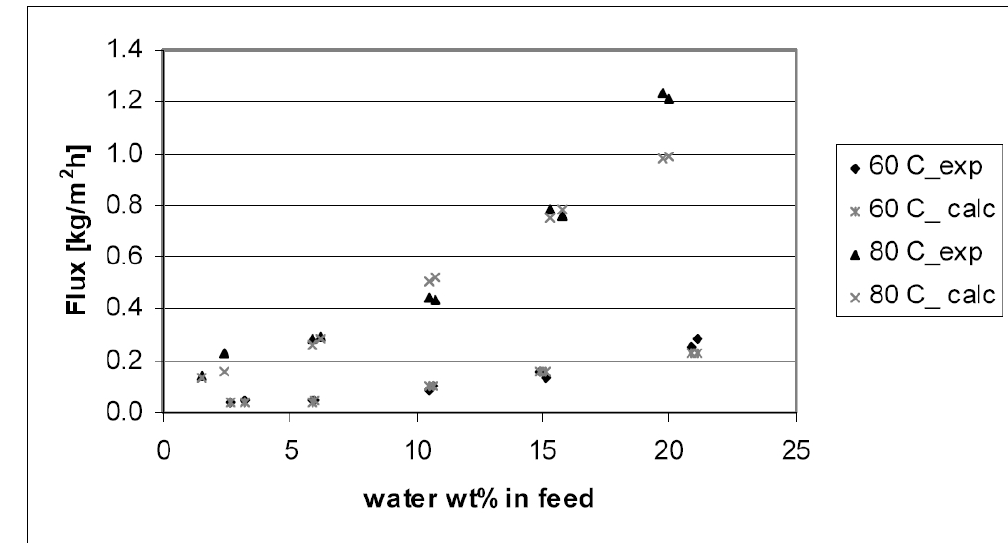
Fig. 4 Experimental and modelled Flux data by ethanol